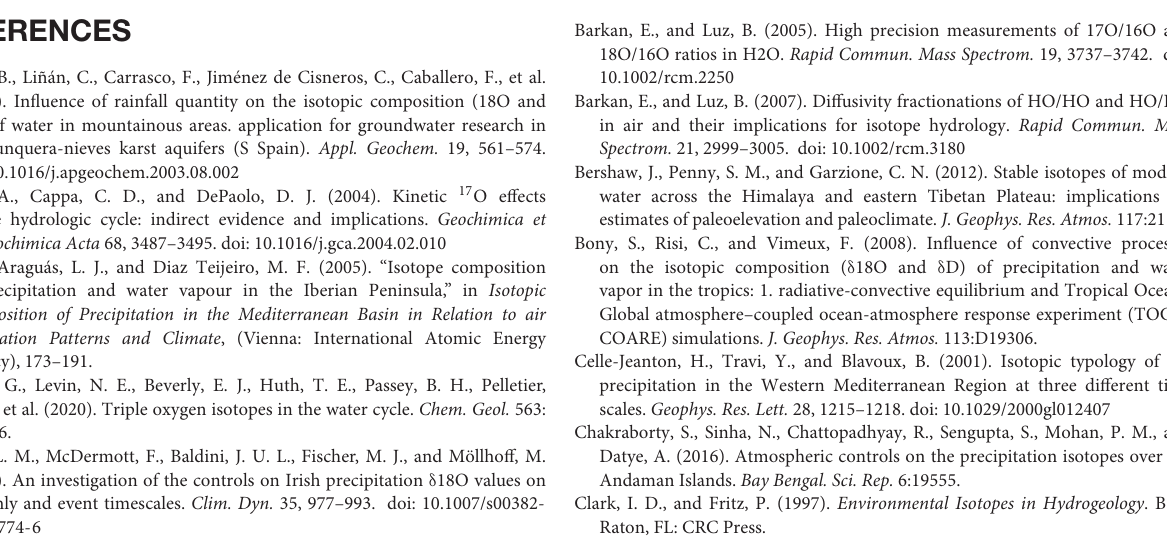
Supplementary Figure 1 | Hundred and twenty hour backward-trajectory analysis at 850 hPa for each precipitation event of this study, clustered by seasons. Earth model from Google Earth. Supplementary Figure 2 | Graphical description of the four meteorological patterns associated with rainfall events in Villanúa during the study period, using maps of 300 hPa geopotential height and 500 hPa (right column) and sea level pressure and 850 hPa temperature (left column). SAA, Strong Atlantic Anticyclone pattern. AD, Atlantic Depression pattern. AR, Anticyclonic Ridge pattern, and CL, Cut-off Low